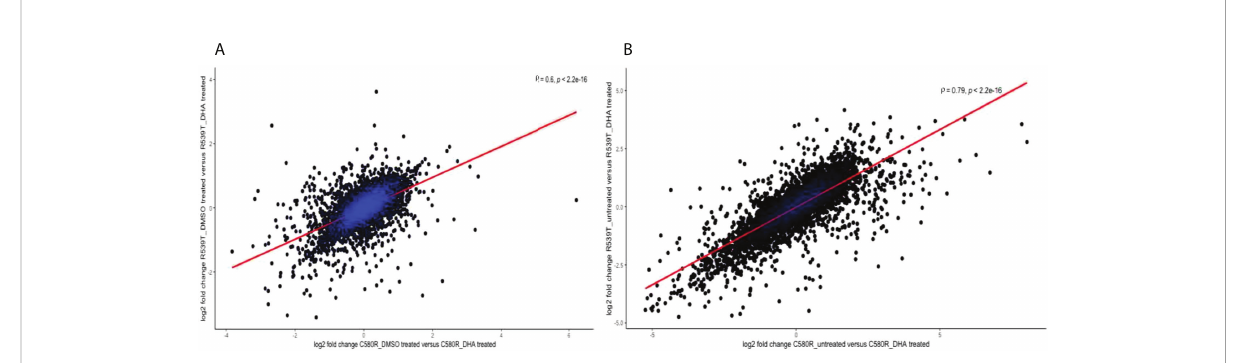
FIGURE 8 Scatter plots showing the strength of the correlation between the two ARTr biological replicates (C580R and R539T) for the compared conditions: (A) DMSO_treated versus DHA_treated and (B) untreated versus DHA_treated. The analysis explored the underlying heterogeneity in the gene expression pro fi le between C580R and R539T and shows poor to moderate correlation in gene expression pro fi le. The spearman rank correlation plot was constructed using the log2 fold change values between the compared conditions. r is the Spearman coef fi cient of